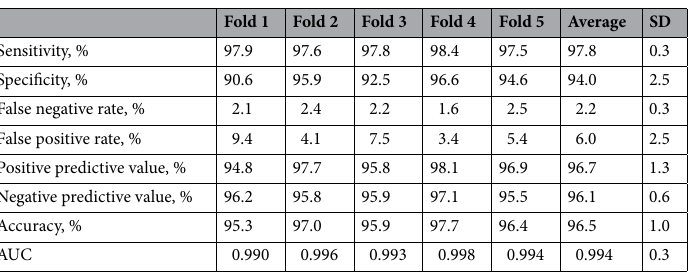
Table 3. Performance of the DL model in the validation data set. AUC the area under the receiver operating characteristic curve, SD standard